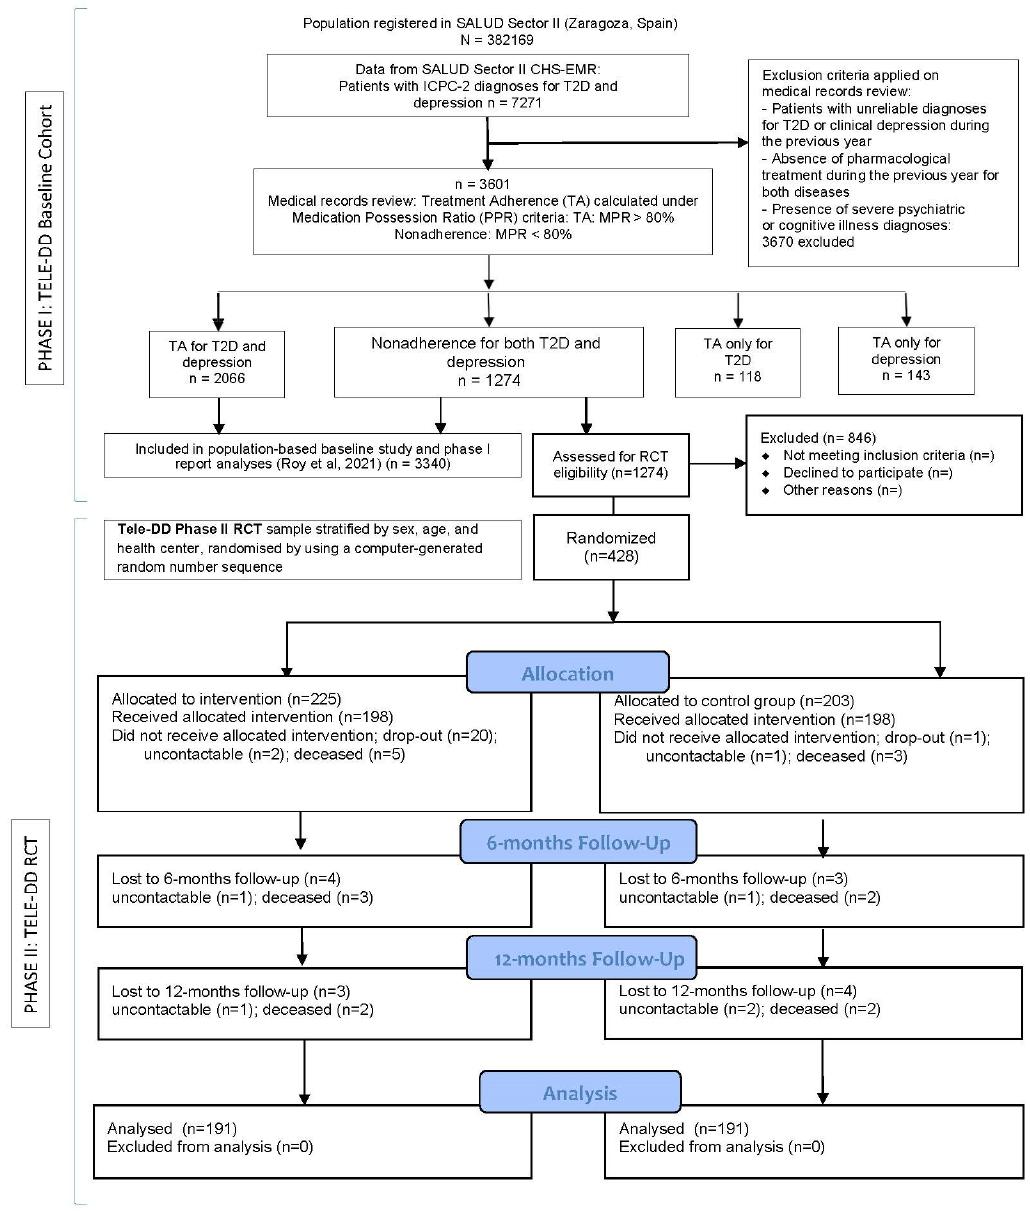
Figure 1. Flow diagram demonstrating the TELE-DD Project population data cohort (Phase I) and RCT sample randomisation, allocation, and follow-up (Phase II).